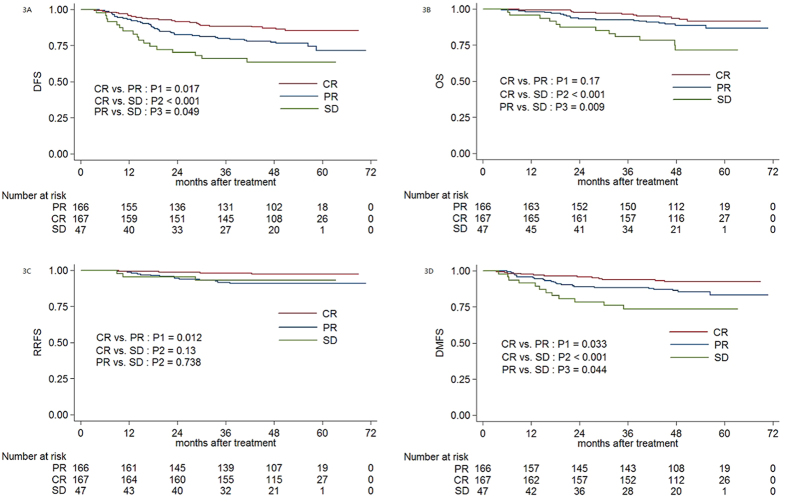
Kaplan-Meier DFS (3A), OS (3B), RRFS (3C) and DMFS (3D) curves for 399 patients with NPC receiving IMRT stratified as the CR, PR and SD groups based on the regional tumour response after induction chemotherapy. Abbreviations: DFS = disease-free survival; OS = overall survival; RRFS = regional relapse-free survival; DMFS = distant metastasis-free survival. CR = complete response; PR = partial response; SD = stable disease.